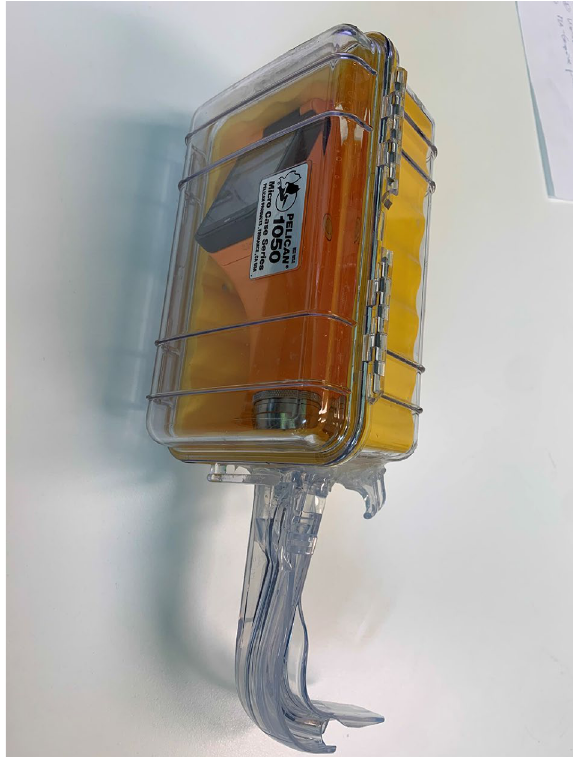
Figure 1. Video laryngoscopy with the PENTAX AWS in a PELICAN 1050 underwater case.